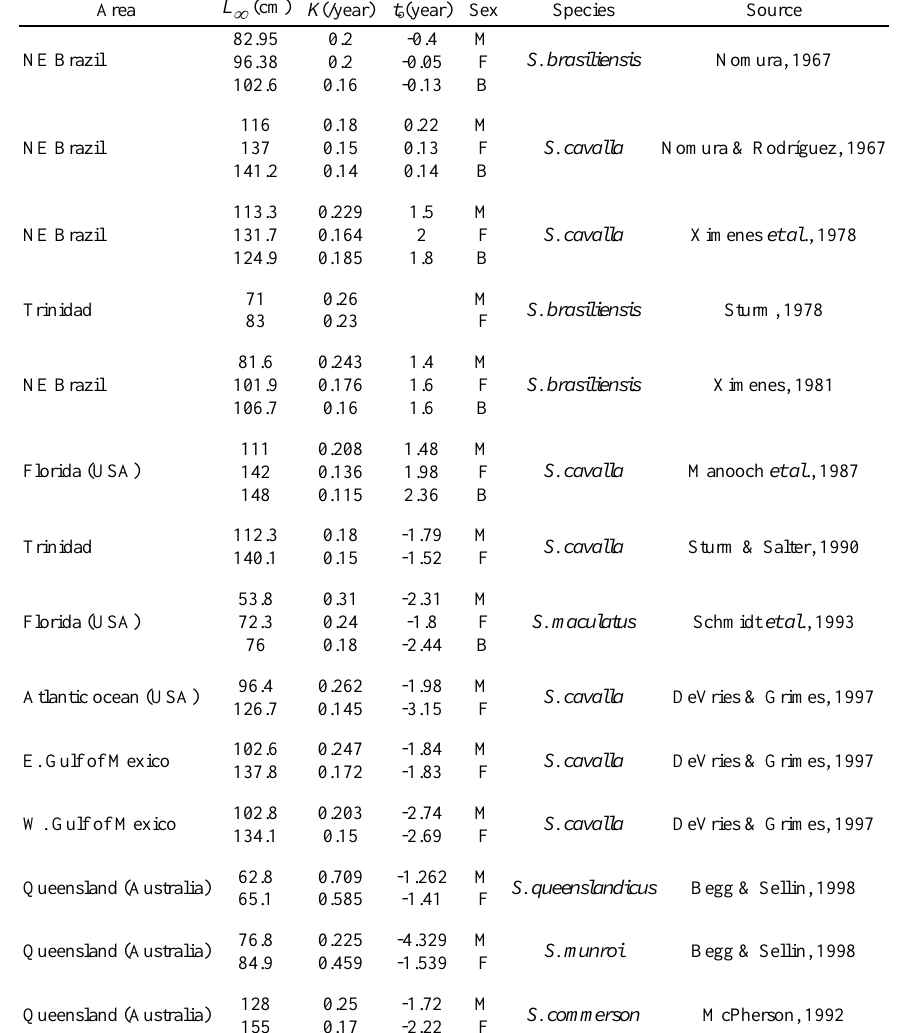
Table 1. Parameters of von Bertalanffy growth based on otolith analysis for Scomberomorus species carried out in the world ( L in fork length; M = males; F = females; B = both sexes ∞